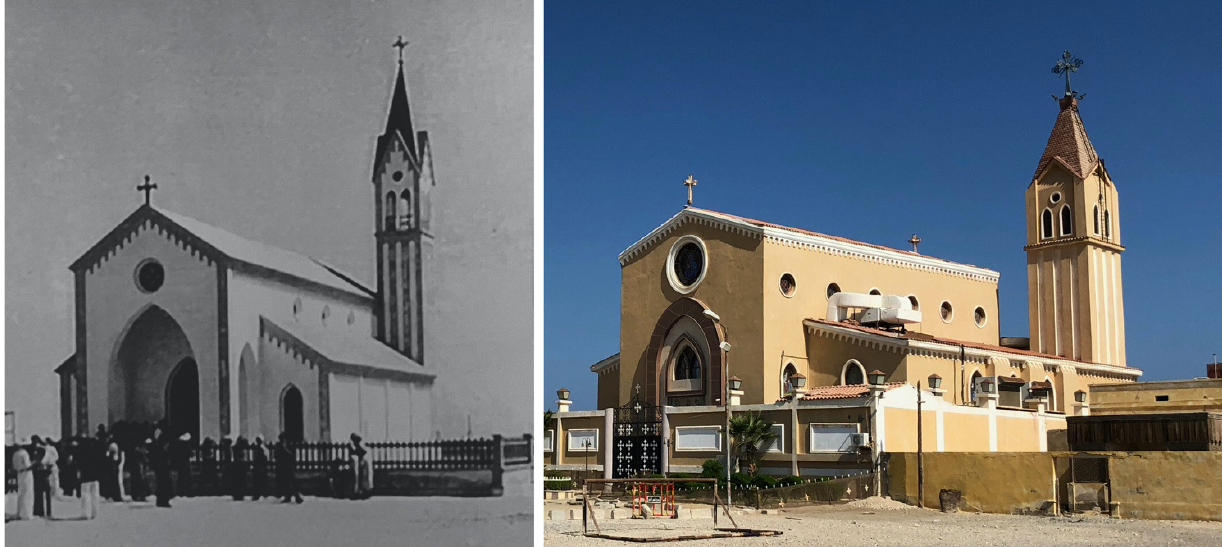
Figure 5. The Franciscan church in the coastal industrial plant, presumably during the 1930s (left); the reconstructed church, now serving Egyptian Copts (right). Sources: Pellegrini (2011, p. 112; left) and photo by Mirhan Damir (2018; right). patterns of stratification. The company employed about 2,000 workers, of which only 100 were Italian (Pellegrini, 2011, p. 27). Italians were divided into two social groups according to their positions. Those occupying high‐ ically and socially separated from the old town and its res‐ in the desert industrial plants (Pellegrini, 2011, p.